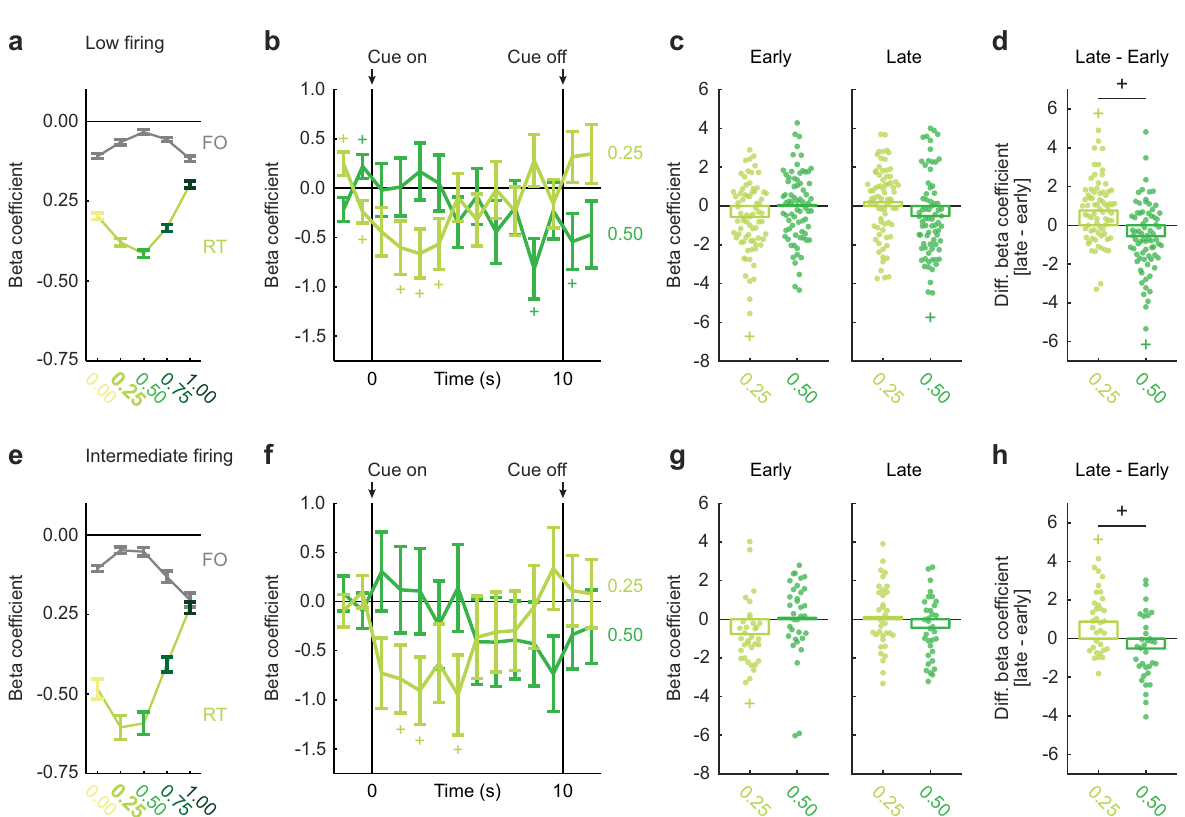
fi ve uncertainty assignments. Low fi ring neurons more strongly signaled relative threat, compared to fear output, across all fi ve assignments (Fig. 4a). Relative threat signaling was better